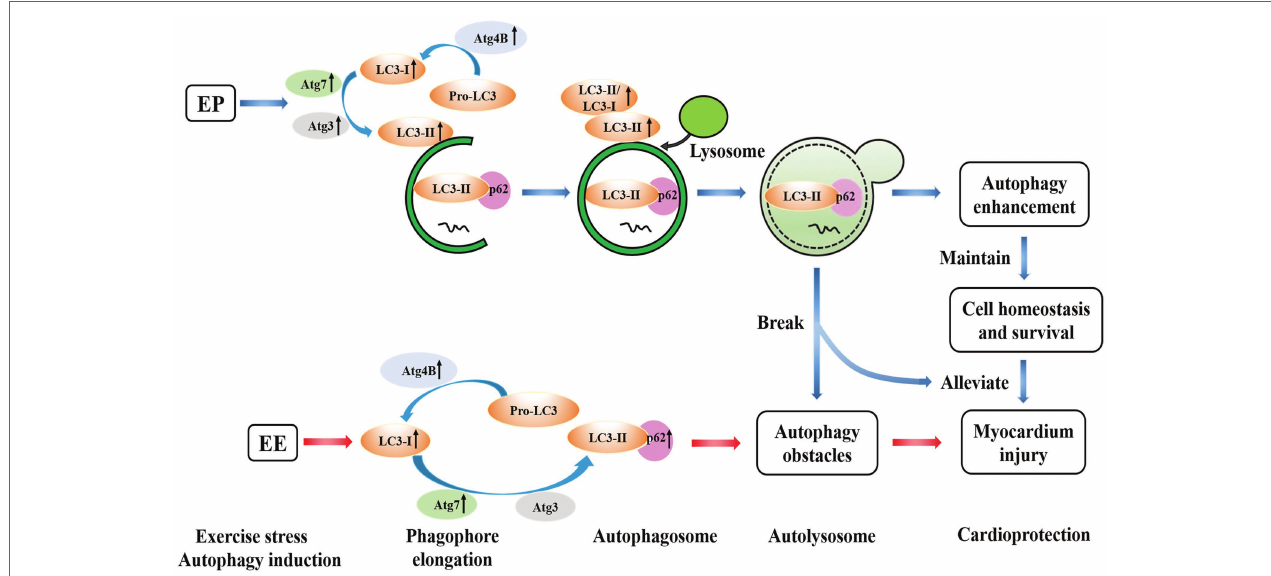
FIGURE 10 | Possible mechanisms of EP alleviating exhaustive exercise-induced injury. EP may promote autophagy to maintain cell homeostasis and survival, which cooperates for cardioprotection of alleviating exhaustive exercise-induced myocardial injury by increasing LC3 lipidation-associated